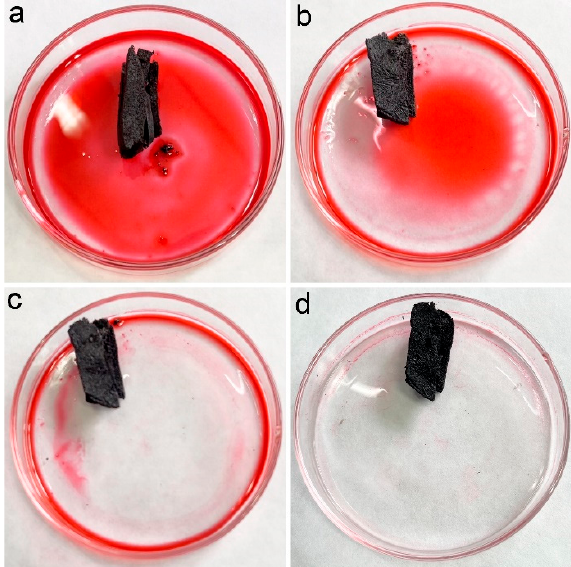
Figure 4. Removal of chloroform (dyed with Sudan red 5B) by PCS. ( a ) chloroform (dyed with Sudan red 5B) before PCS addition (0 s), ( b ) PCS removes chloroform (dyed with Sudan red 5B) for 16 s, ( c ) PCS removes chloroform (dyed with Sudan red 5B) for 32 s, ( d ) PCS removes chloroform (dyed with Sudan red 5B) for 48